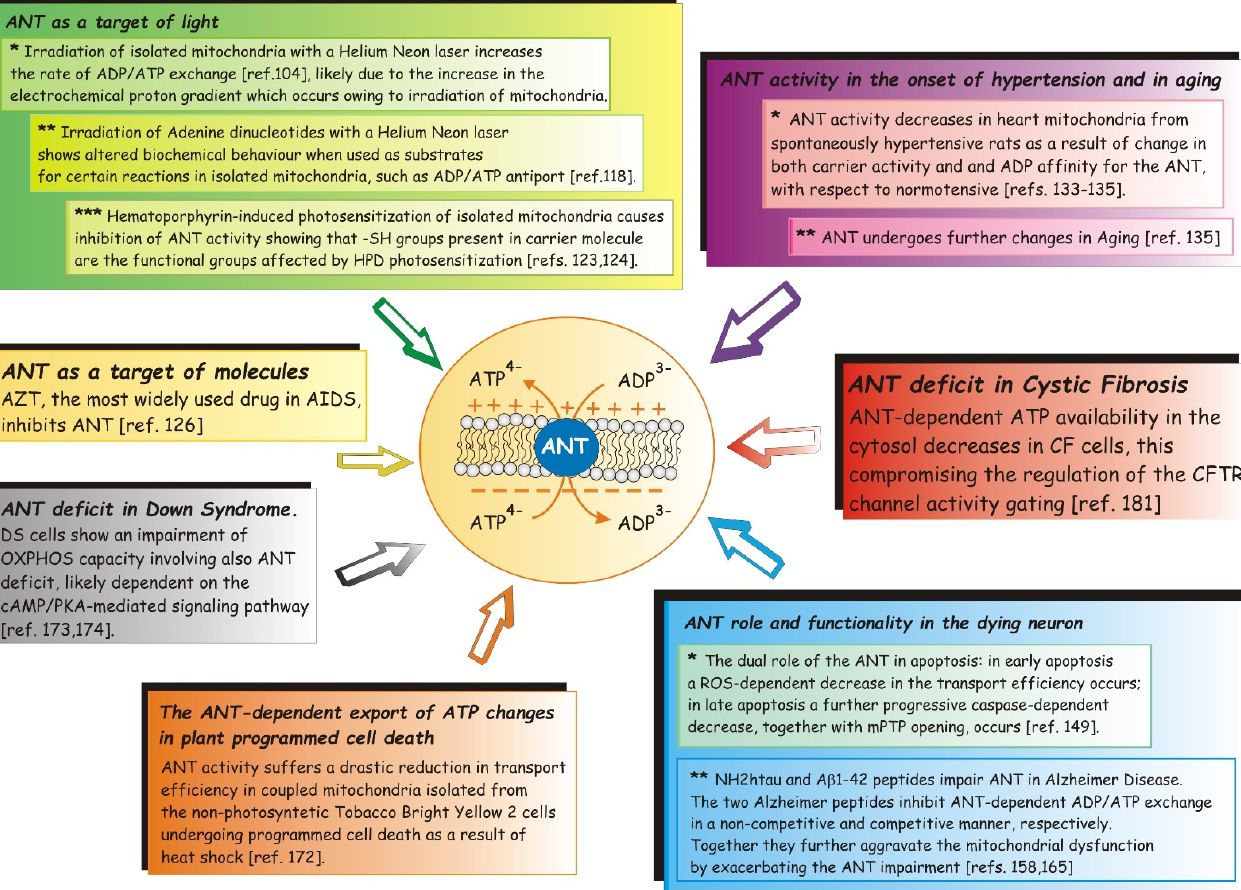
Figure 2. ANT is the target of light or molecules or even of the two Alzheimer’s proteins and its activity is impaired under various pathological conditions affecting the host cell.